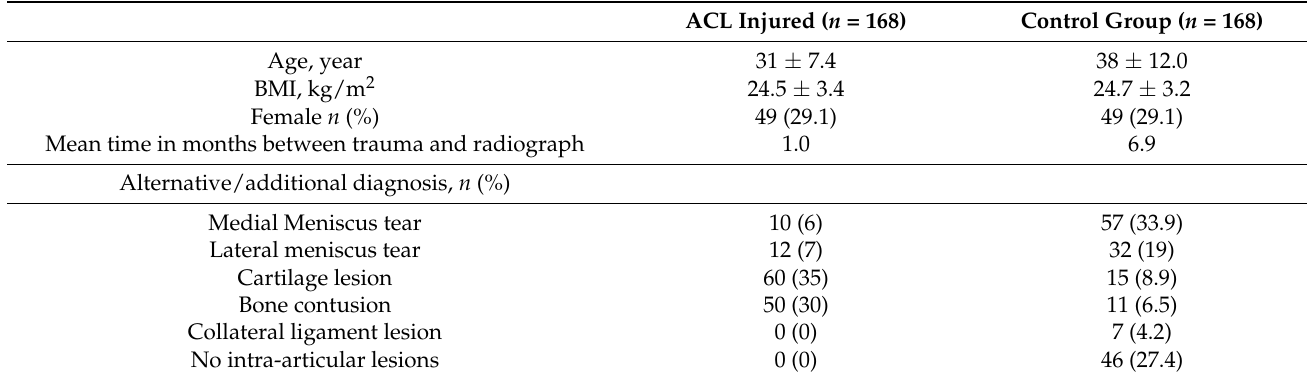
Table 1. Baseline demographic variables.